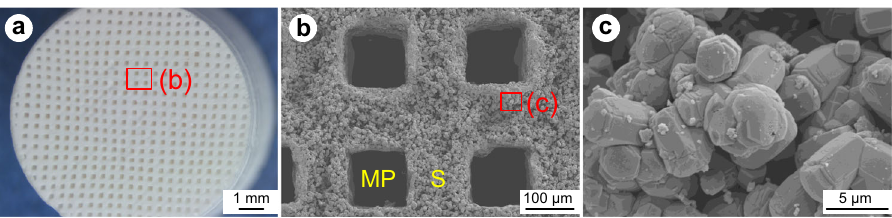
Fig. 3 Stereomicroscopy and SEM images of CO 3 Ap HCBs. Stereomicroscopy image of a CO 3 Ap HCB ( a ). SEM image of a CO 3 Ap HCB ( b , c ). “ S ” and “ MP ” indicate a honeycomb strut and macropore, respectively. Magni fi ed SEM images of the struts of the CO